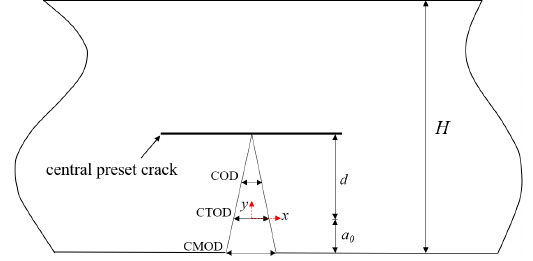
Figure 5. The crack opening displacements of the propagating crack.